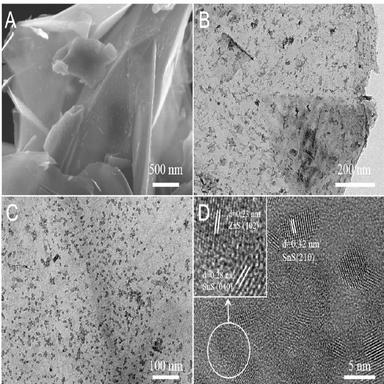
(A) SEM, (B, C) TEM and (D) HRTEM images of ZnS-SnS@C/EG composite.